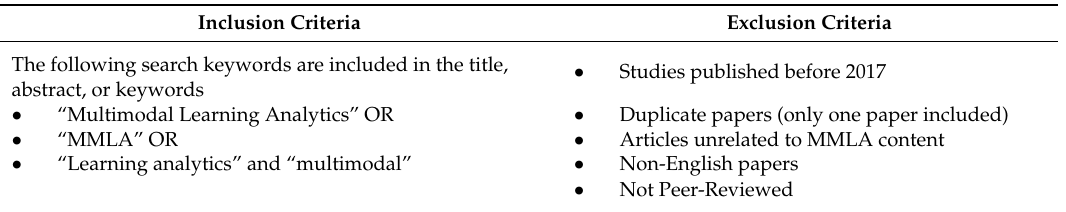
Table 1. Inclusion and Exclusion Criteria for Reviewing Papers.